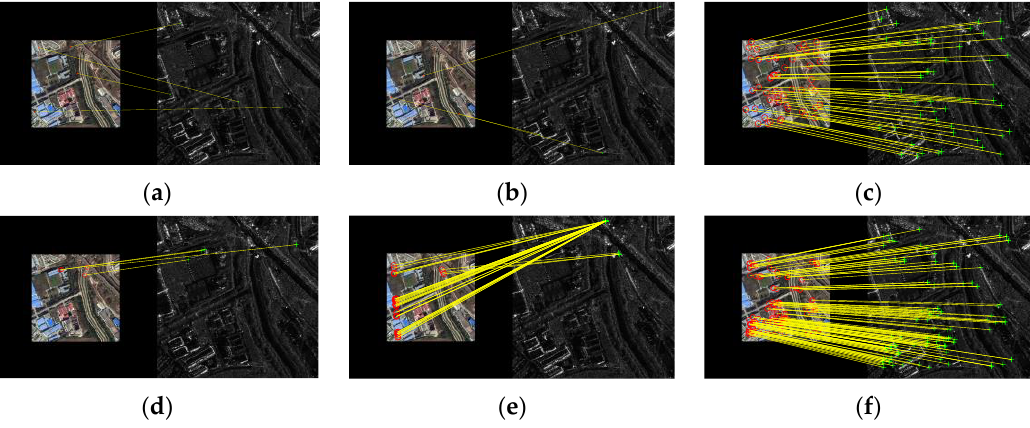
Figure 13. Experimental results of pair 1. The registration results from ( a ) to ( f ) are SIFT, SAR-SIFT, OS-SIFT, HOPC, RIFT, and MSPCO, respectively.